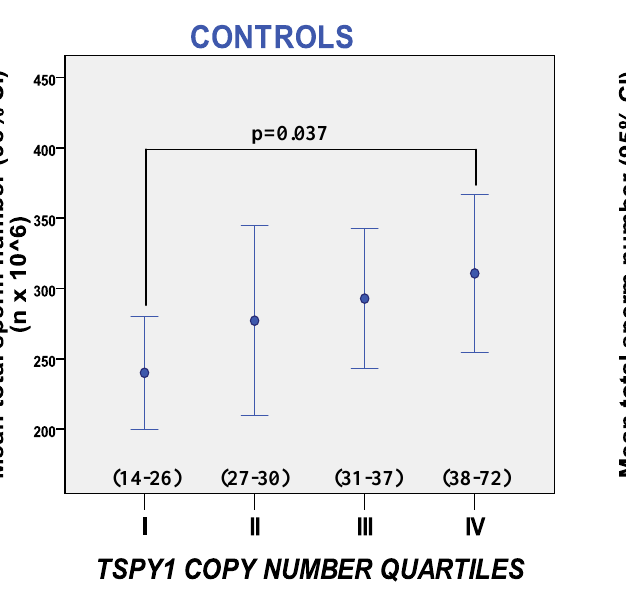
Figure 1. Mean total sperm number in each quartile defined on the basis of TSPY1 copy number, within patients and controls. The mean total sperm number is significantly higher in the fourth quartile ( i.e. , in men with higher TSPY copy number) with respect to the first quartile in both groups in our enlarged study population (n =